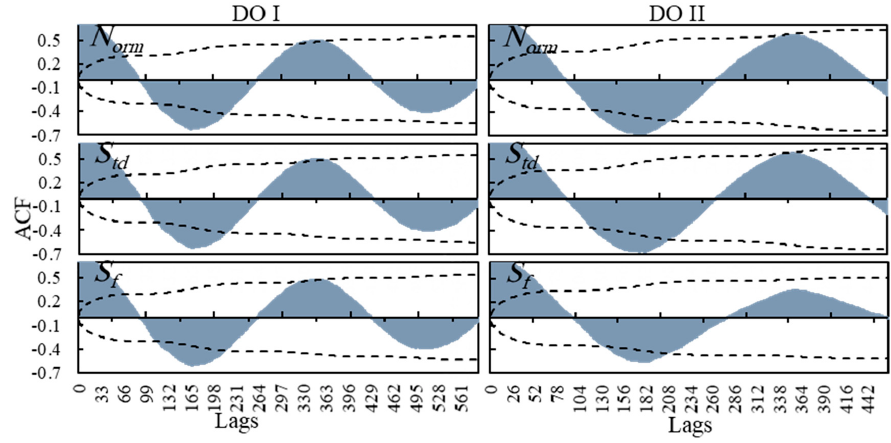
Figure 4. Autocorrelation function plot of the preprocessed DO data.